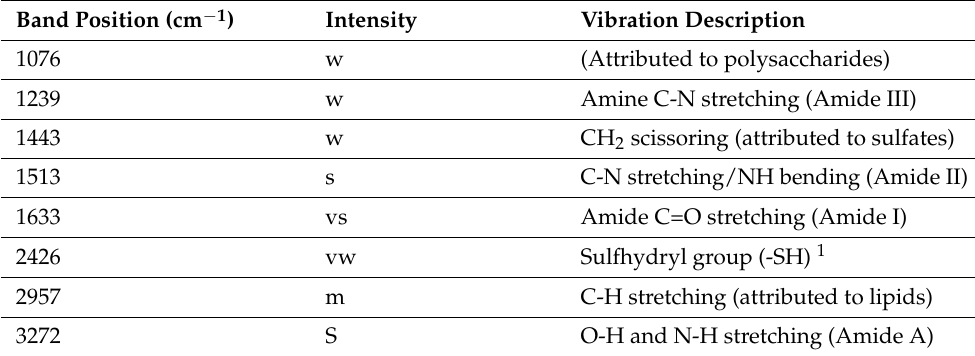
Table 3. FTIR vibrational bands observed in the ESM (m: medium, s: strong, v: very, w: weak), table based on [58,60,63,70,96,113–115].